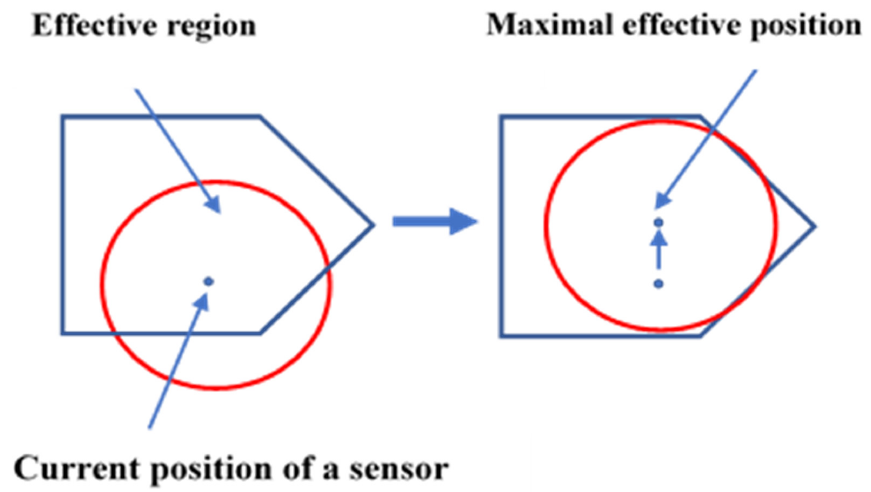
Figure 9. The effective region and the maximal effective position.